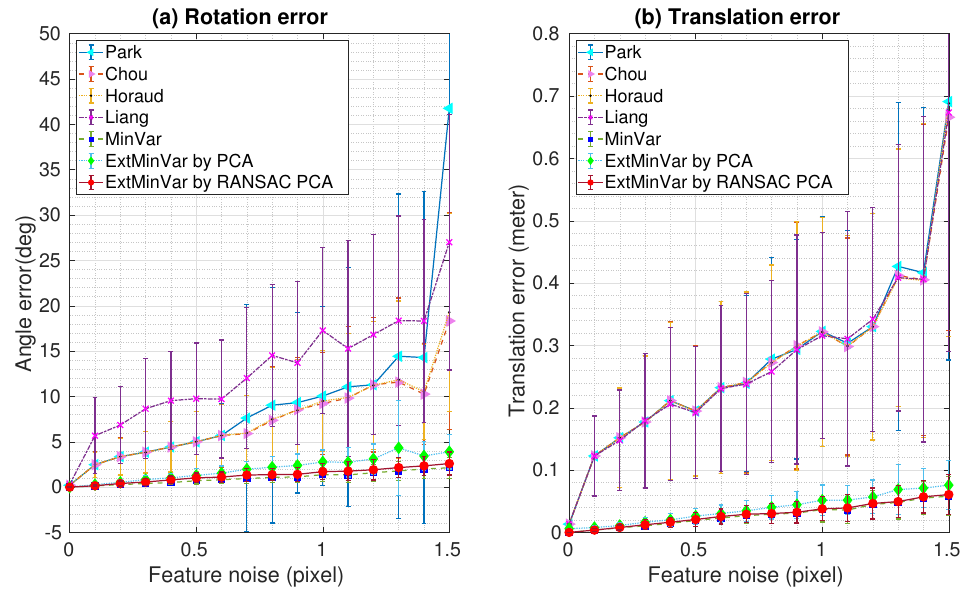
Figure 9. Experimental results using synthetic data with feature noise [0–1.5 pixel]: ( a ) Rotation error; ( b ) Translation error. PCA: principal component analysis; RANSAC: random sample